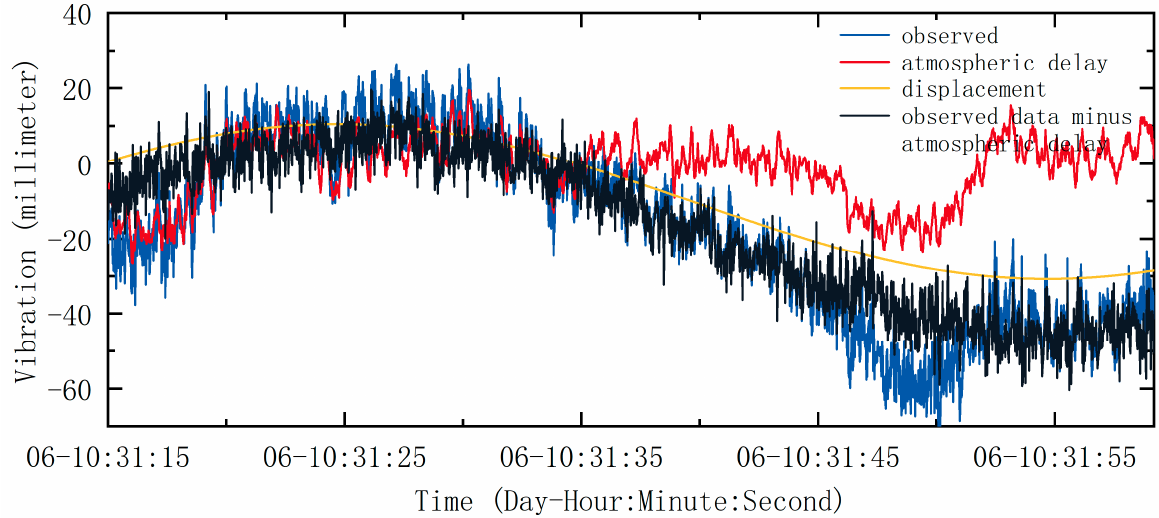
Figure 8. The solution at the 935th pixel. The blue line represents the observed vibration of the bridge, the red line represents the atmospheric delay, the yellow line represents the vibration fitting line, and the dark line represents the difference value between the original observed displacement data and the atmospheric delay.